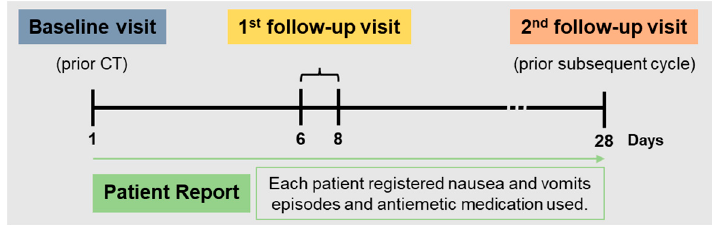
Figure 1. Schematic process of data collected during the study.